Question: Write a caption explaining this figure to a reader.
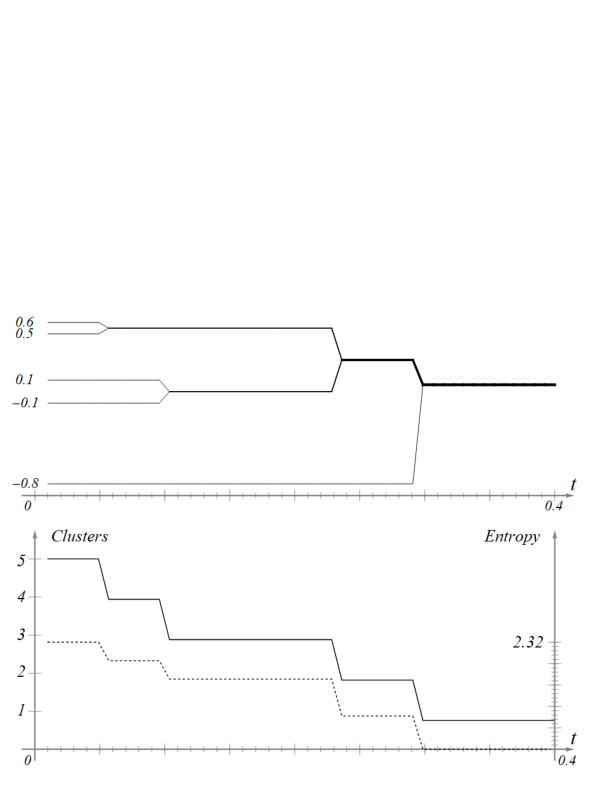
Answer: Above: The chronodendrogram for the dataset with five elements; linkage weights are indi- cated by thickness. Below: The two informational measures, Mk and Sk, as a function of time.